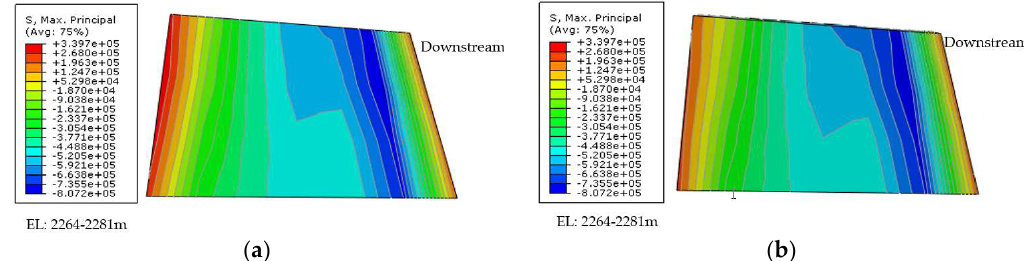
Figure 16. The first principal stress at the right arch abutment from EL 2264 m to 2281 m (Unit: Pa). ( a ) Before reinforcement; ( b ) after reinforcement.